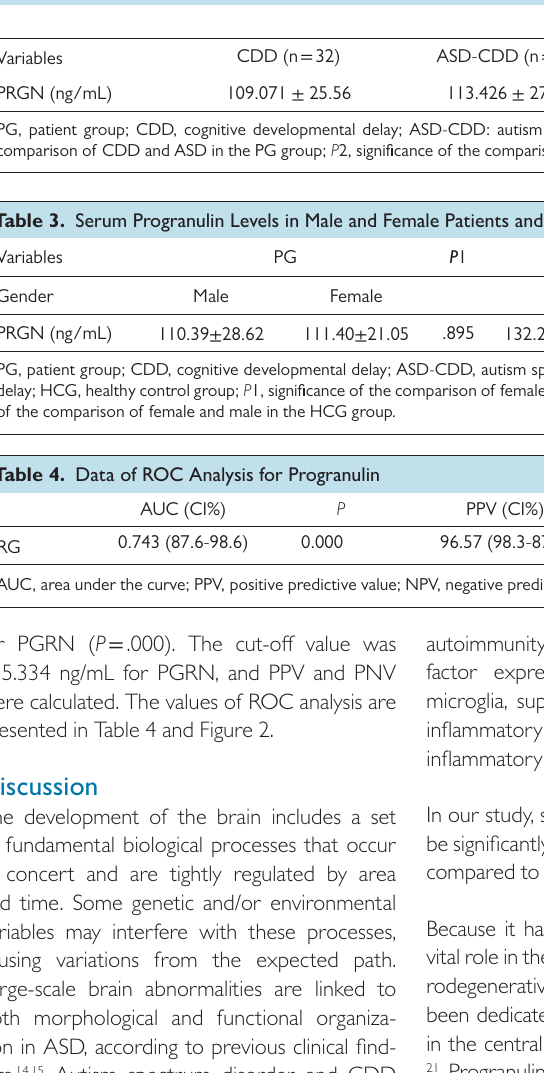
Table 2. Progranulin Levels of the Healthy Control and Patients Groups